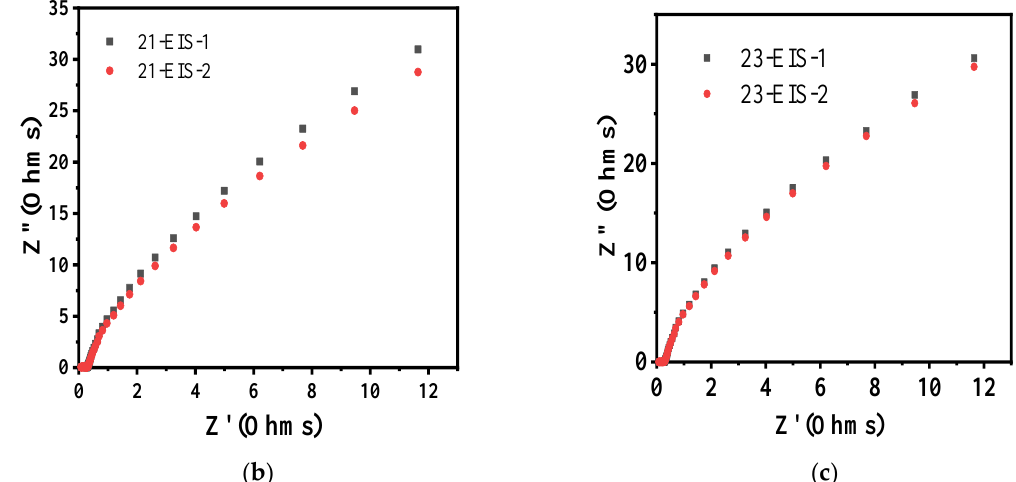
Figure 4. Transient photocurrent response of ( a ) C 3 N 4 /ZnO where 23 is for 0.4 g C 3 N 4 /ZnO; 21 is for 0.3 g C 3 N 4 /ZnO); ( b ) and EIS Nynquist plots of C 3 N 4 /ZnO, 21-EIS-1 stands for 0.4 g C 3 N 4 /ZnO; 21-EIS-2 stands for 0.3 g C 3 N 4 /ZnO; and ( c ) EIS Nynquist plots of ZnO and defect ZnO. 23-EIS-1 belongs to ZnO; 23-EIS-2 belongs to Defect ZnO.